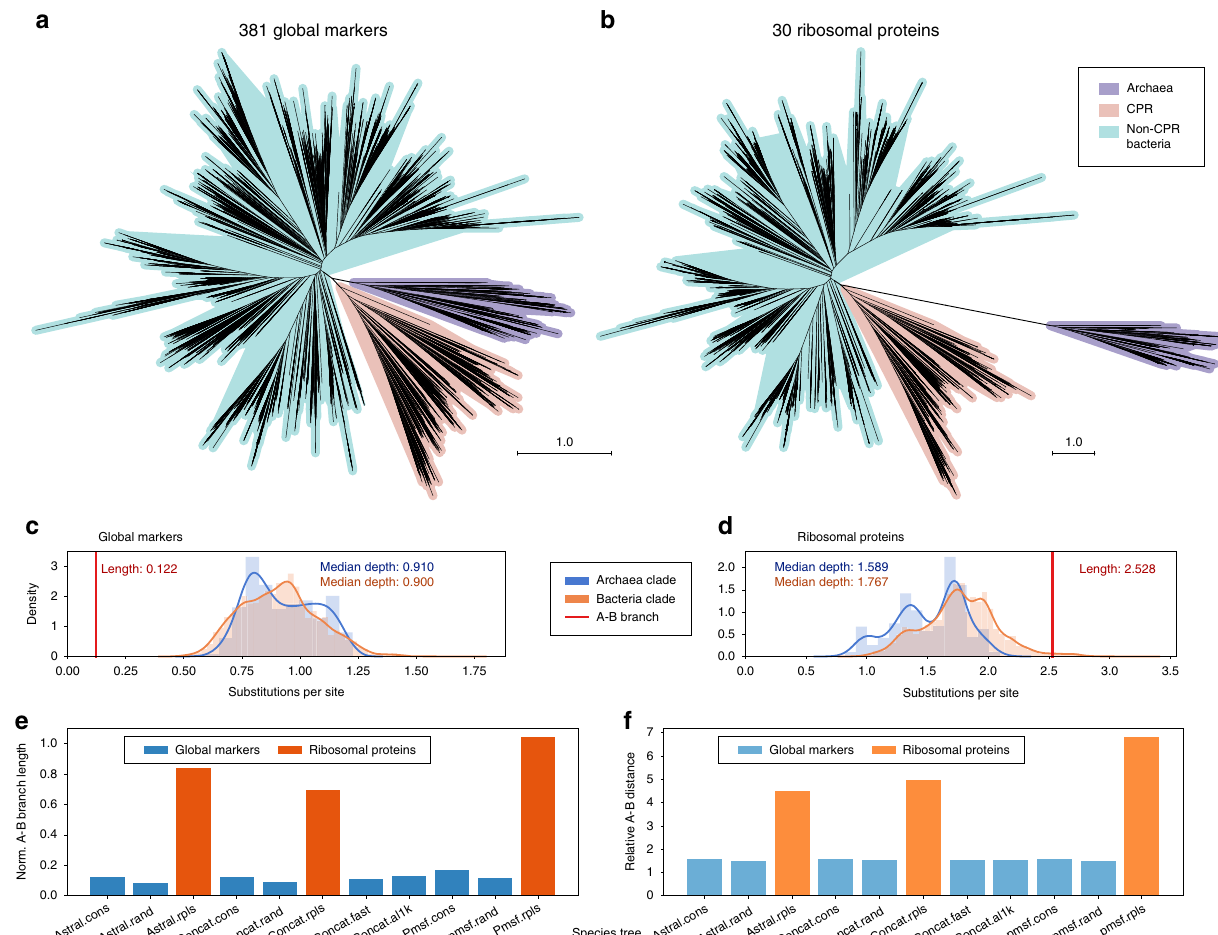
Fig. 4 Evolutionary proximity between domains Archaea and Bacteria. a , b The unrooted, drawn-to-scale ASTRAL tree with branch lengths estimated using the 381 global marker genes (conserved site sampling) ( a ) or using the 30 ribosomal proteins ( b ) are displayed, with color codes highlighting domain-level relationships (Archaea and Bacteria, the latter of which consisting of CPR and non-CPR Bacteria). Scales are in the unit of the number of substitutions per site. c , d For each domain (blue: Archaea, orange: Bacteria), the histogram and Gaussian kernel density function of the depths of all descendants (sums of branch lengths from a tip to the lowest common ancestor (LCA) of the clade) are plotted, with the median depth displayed; the length of branch connecting the LCA of A(rchaea) and the LCA of B(acteria) is marked as a red vertical line, with its value displayed. e , f Evolutionary distance between domains Archaea and Bacteria by multiple trees (tree names follow Fig. 3), among which the branch lengths of the ASTRAL tree were estimated using differential gene and site samplings, respectively. Two metrics are displayed: the A – B branch length normalized by the median depth of all tips in the tree ( e ), and the relative distance between Archaea taxa (tips) and Bacteria taxa ( f , see the Methods section). Color codes highlight evolutionary distances indicated by differential gene samplings (blue: the 381 global marker genes, orange: the 30 ribosomal proteins). Source data are provided as a Source Data fi